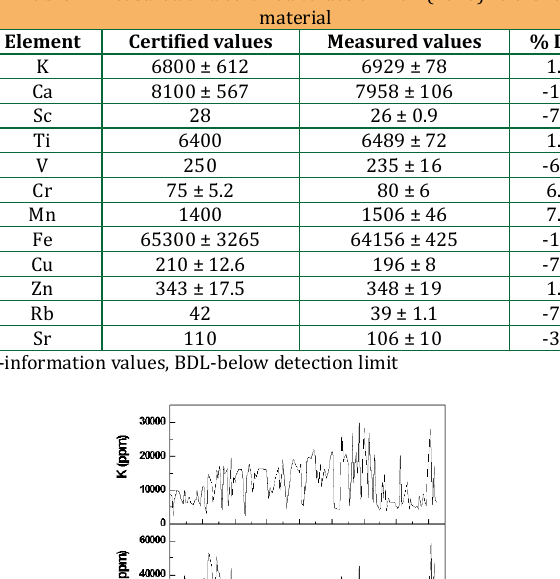
Table 1: Measured and certified values of NIST (1515) reference Element